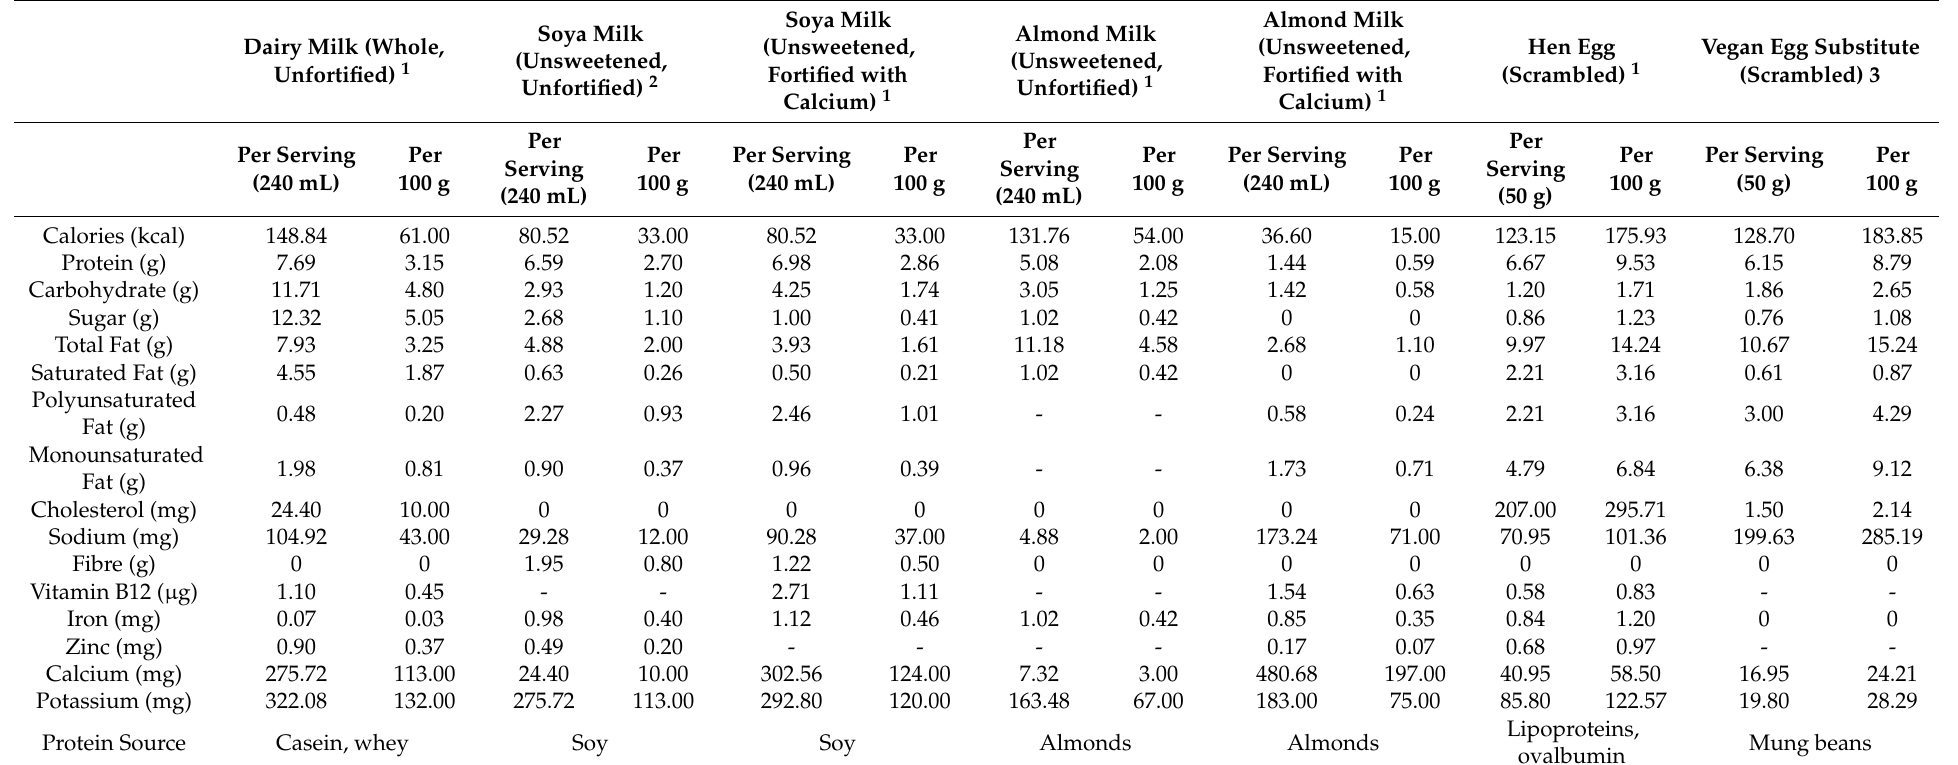
Table 6. Comparison of dairy and dairy